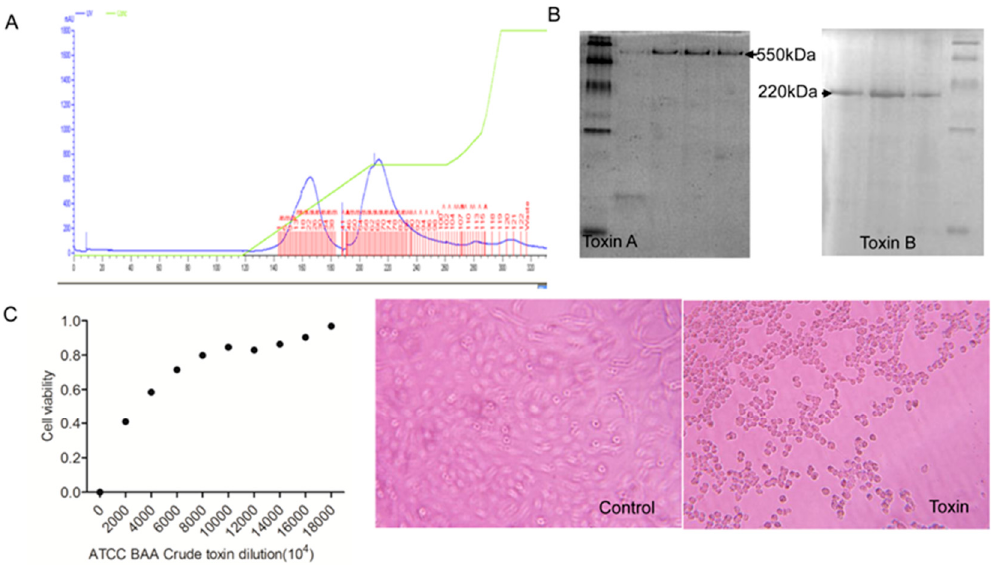
Figure 2. Activity analysis of crude toxins of wild-type strain C. difficile ATCC BAA-1870. ( A ) Purification of crude toxins of C. difficile ATCC BAA-1870. The first peak is toxin A, the second peak is toxin B. ( B ) Native-PAGE of purified toxins (predicted TcdA and TcdB molecular weights are 550 KD and 220 KD). ( C ) Toxicity of crude toxins was determined by Vero cell viability analysis.